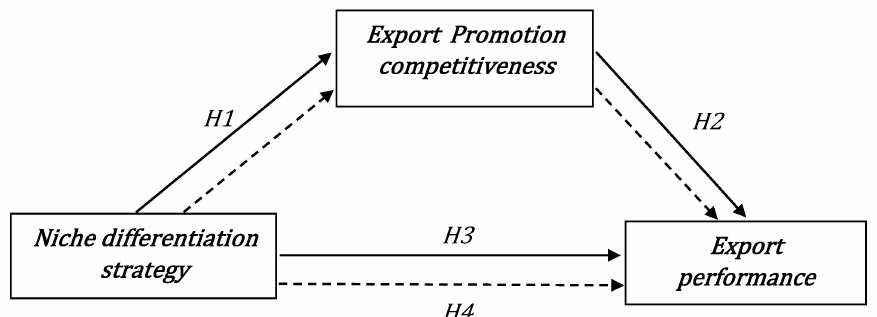
Figure 1. Hypothesis